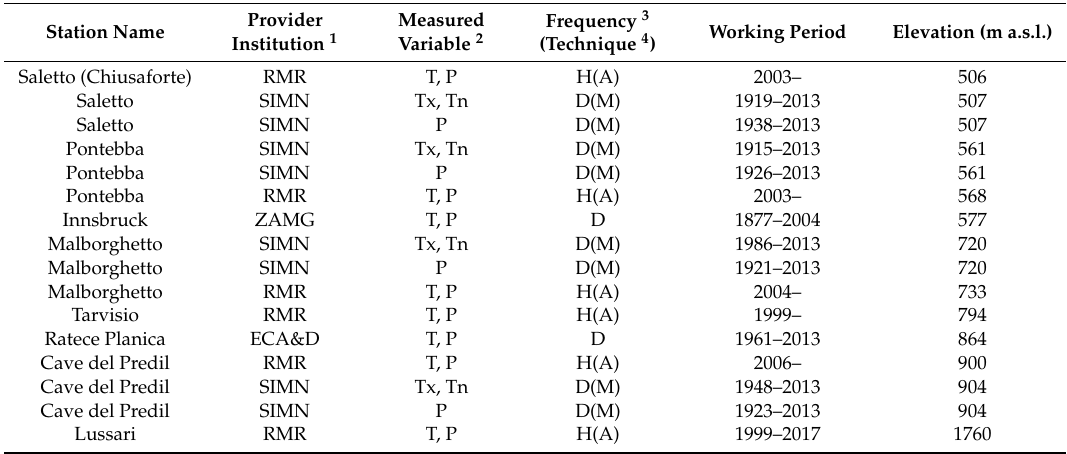
Table 2. Characteristics of the weather stations and meteorological data used in this